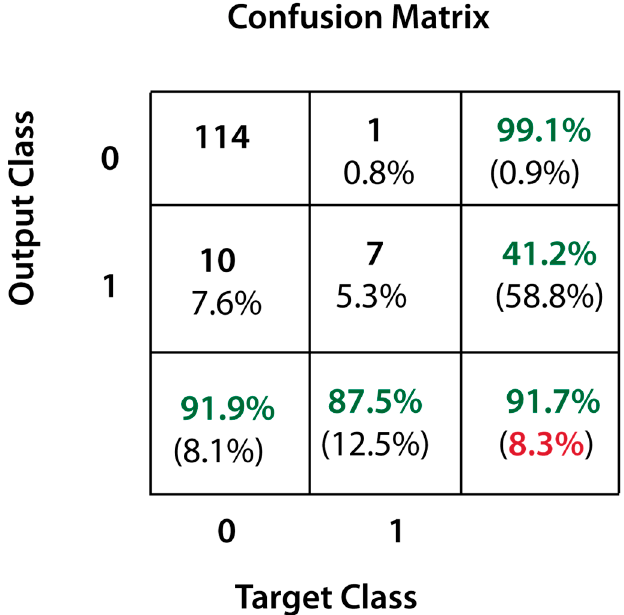
Figure 4. Confusion matrix of the classification results achieved in the fresh (first column) and spoiled (second column) vanilla cream samples.